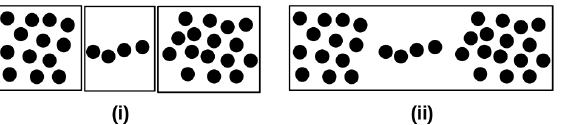
Figure 6. Emphasizing the difference in the conceptualization of the Gestalt principle of proximity in ( i ) the approach introduced in [29] and ( ii ) our